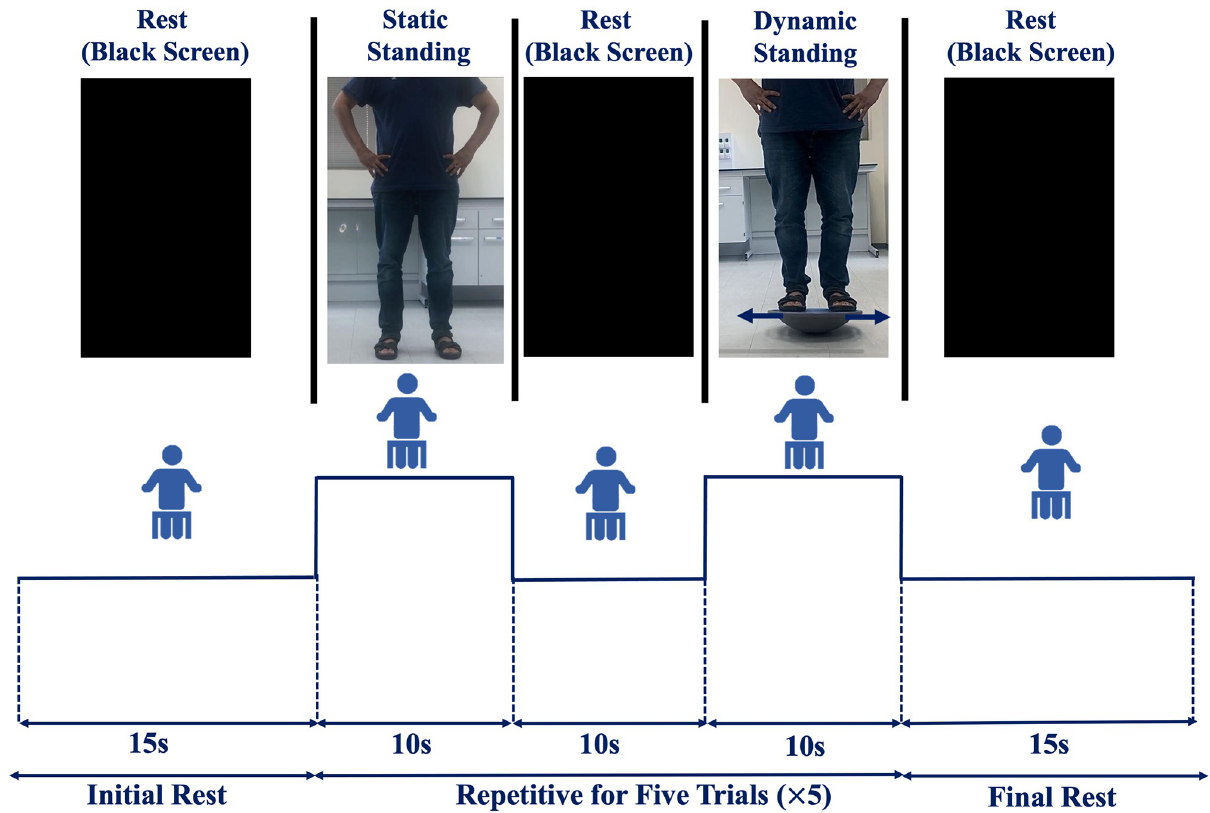
Fig 2. Experimental paradigm of the three (AO, AO+MI, and MI) experiments. Subjects watched two videos: static standing balance task (normal standing) and dynamic standing balance task (balancing a mediolateral perturbation), during two experiments: (AO) and while imagining themselves as the person performing the tasks (AO+MI). During the third experiment, participants verbally instructed, through previously recorded voice instructions, to close their eyes and imagine themselves performing static and dynamic balance tasks. Each subject repeated each task five times with a resting period of 10s between the two balance